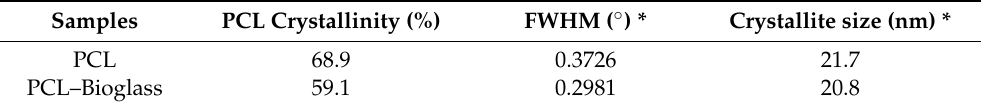
Figure 8. The XRD patterns of the PCL and PCL – bioglass scaffolds (80/20 wt%) in the range of 2 θ = 20 – 24. Table 4. The calculated PCL crystallinity in the scaffolds and their crystallite size. * The highest peak (crystal plane 110) was used to calculate the crystallinity and crystallite size.